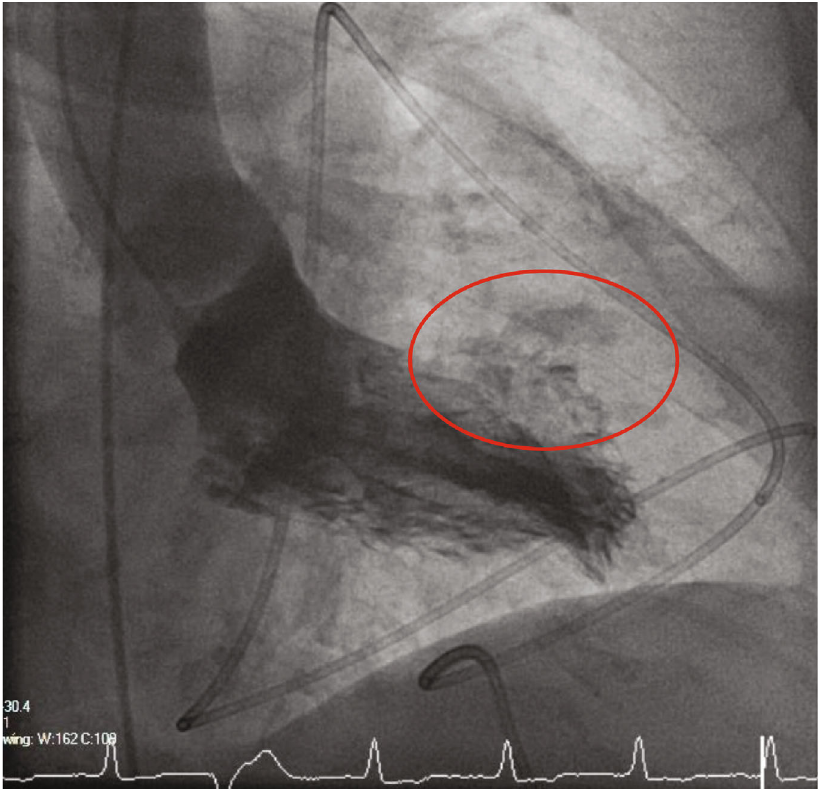
Figure 2: Laevocardiography showing evasion of contrast agent at the anterolateral ventricular